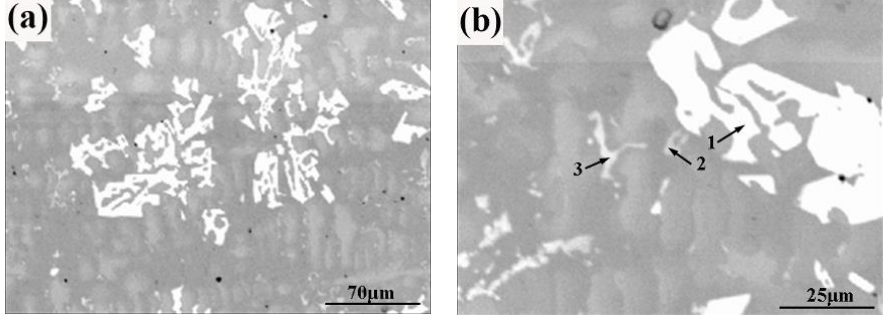
Figure 6. BSE images of the sample B ( a ) low-magnification image; ( b ) high-manification image. Table 4. The EPMA results of points on Figure 6b. Composition is shown in %. Element Ni Cr B Si Fe C W